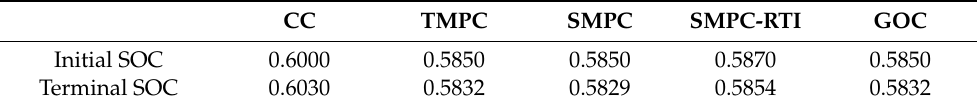
( b ) Figure 14. Engine results for the EC using different speed controllers: ( a ) engine-point distribution and ( b ) histogram of engine speed and torque.